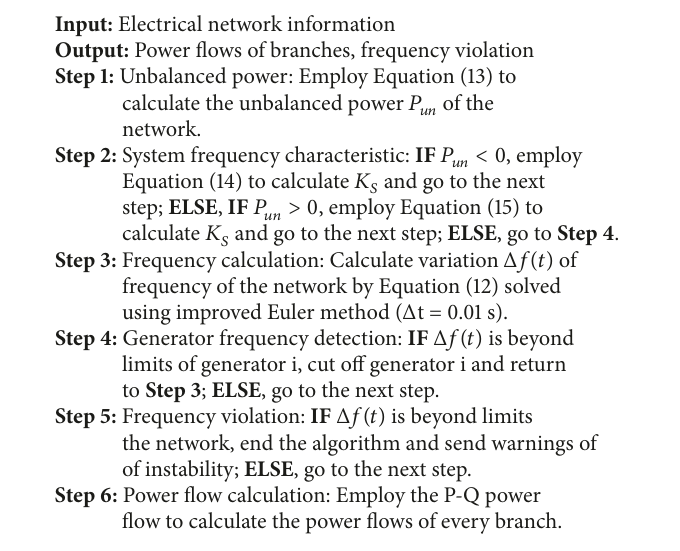
Algorithm 1: Dynamic power flow method.